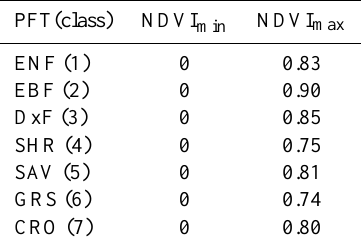
Table A1. Lower (2nd) and upper (98th) NDVI percentiles esti- mated per